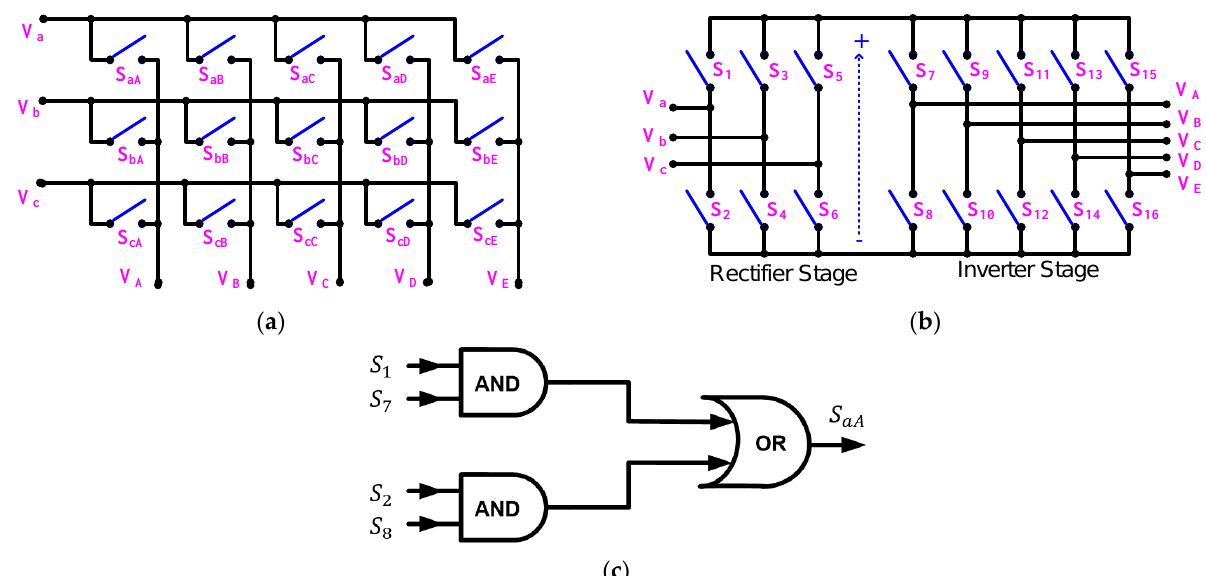
Figure 1. ( a ) Direct five-phase matrix converter (MC), ( b ) indirect five-phase MC and ( c ) transformation from an indirect to direct topology for switch 𝑆 𝑎𝐴 .